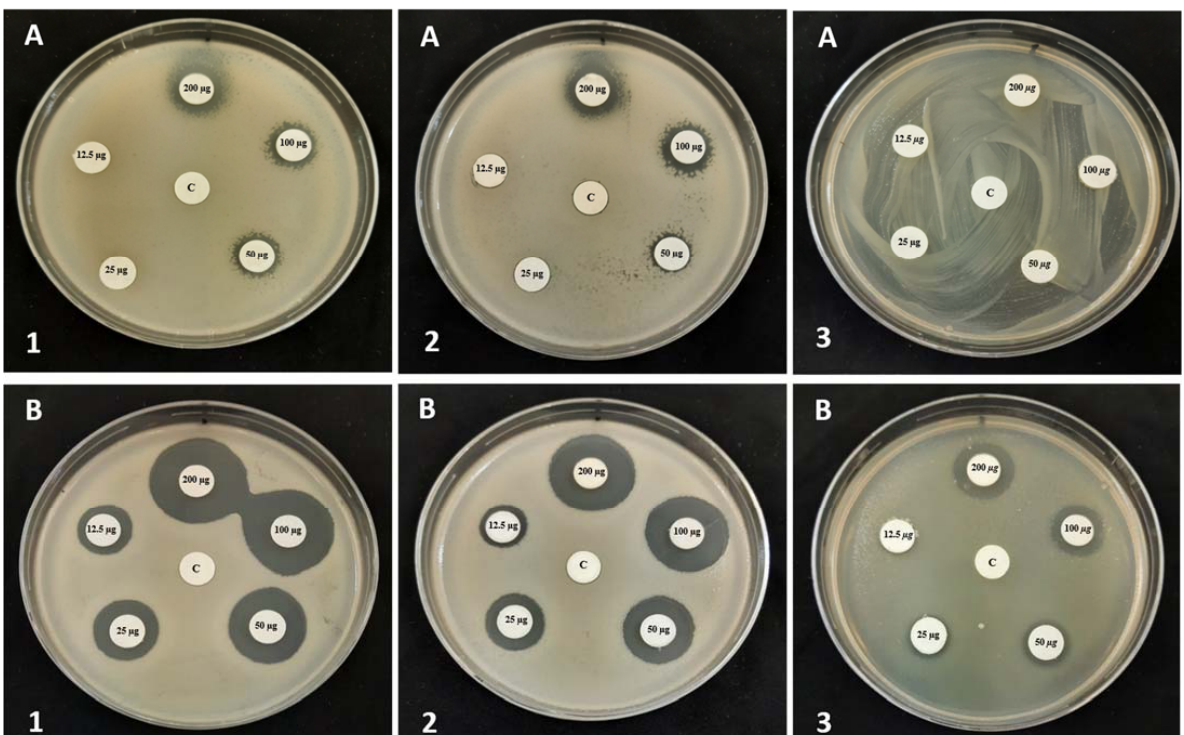
Figure 3. Effect of different concentrations for QHETA-9 (A) and QHETA-14 (B) on the growth of the Gram-negative bacteria A. tumefaciens (1), E. carotovora (2) and E. coli (3). Table 3. Different minimum inhibitory concentrations of QHETA-9 and QHETA-14 against the tested bacterial pathogens.